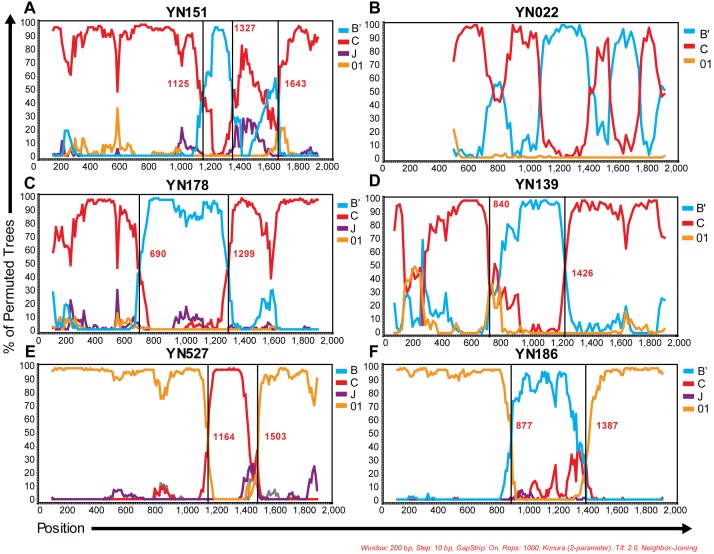
Representative bootscan plots of novel recombinants identified in Banna Prefecture.Simplot bootscan analyses were implemented based on sequences of pol region. YN151 (A) and YN022 (B) represented 4 mosaic B’/C recombinants close to CRF07_BC in phylogenetic tree. YN178 (C) and YN139 (D) served as examples of 8 novel B’/C recombinants carried breakpoints similar to those of CRF62_BC. YN527 (E) represented 2 undefined CRF01_AE/C recombinants and YN186 (F) represented 2 undefined CRF01_AE/B’ recombinants.